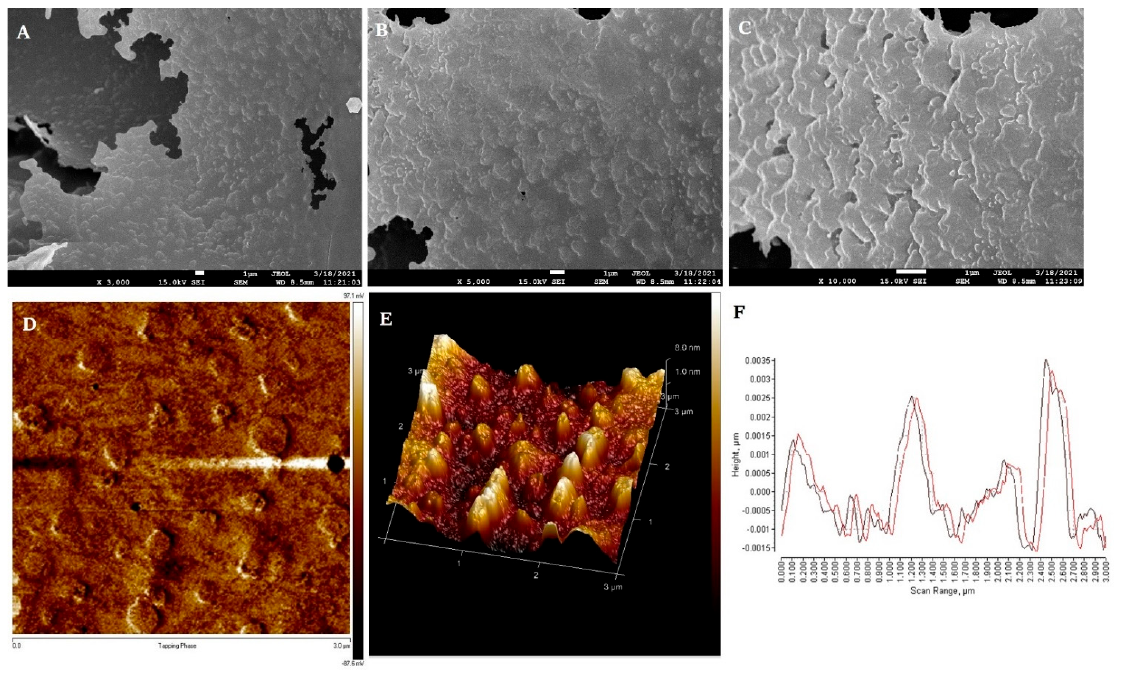
Figure 4. Surface morphology of the EPS produced by B. haynesii CamB6, where ( A ) ×3000 ( B ) ×5000; and ( C ) ×10,000, respectively; ( D ) 2D; and ( E ) 3D AFM images, and ( F ) size distribution patterns.